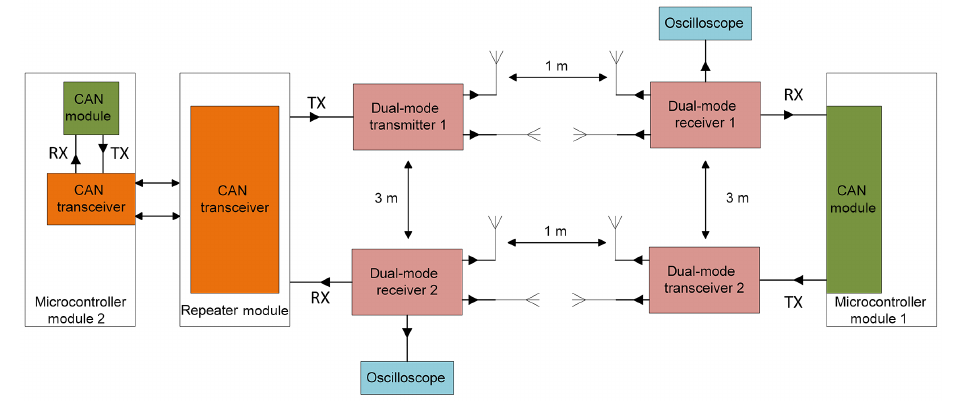
Figure 5. Schematic of the CAN setup using dual-mode radio of the TX and RX